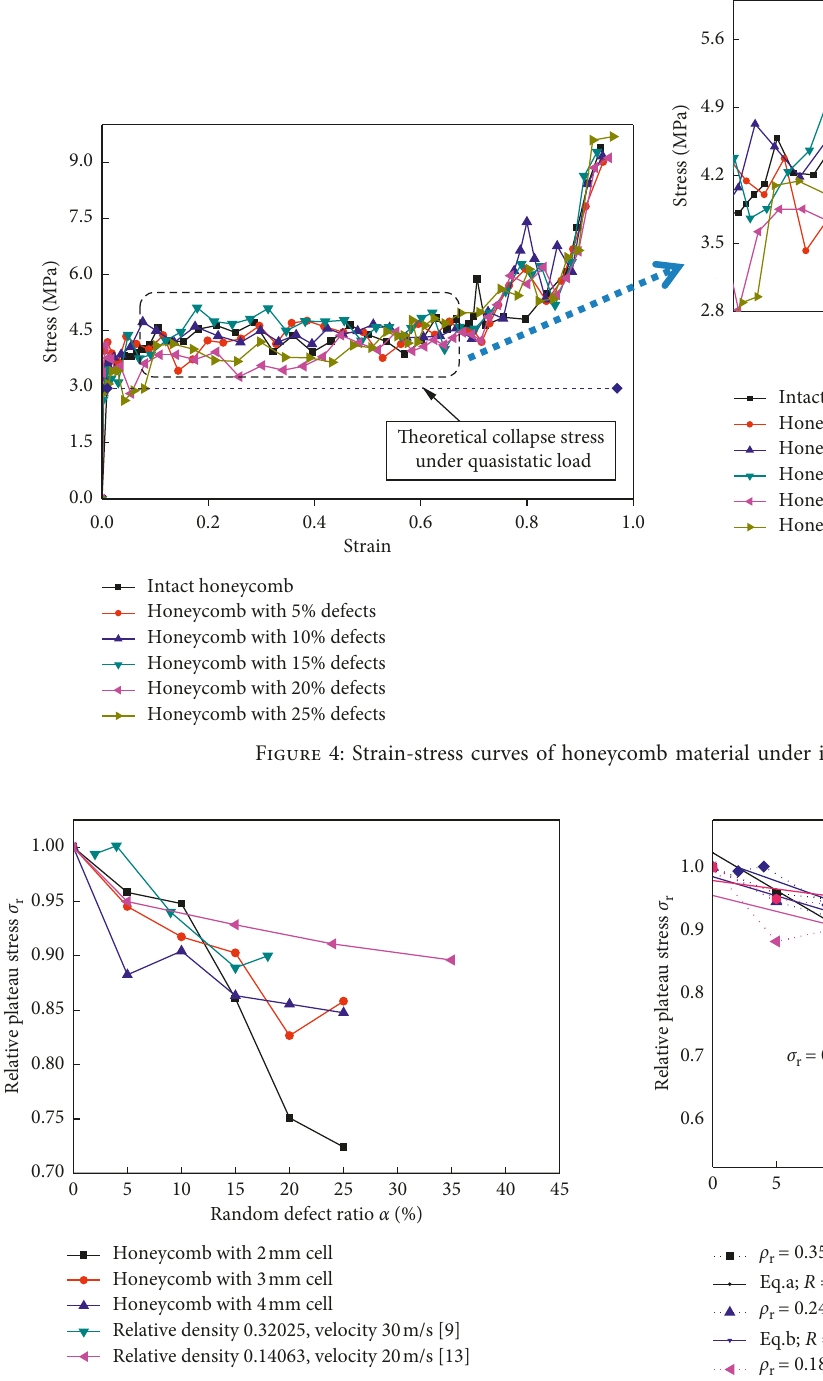
Figure 6: The relative plateau stress with random defects and its